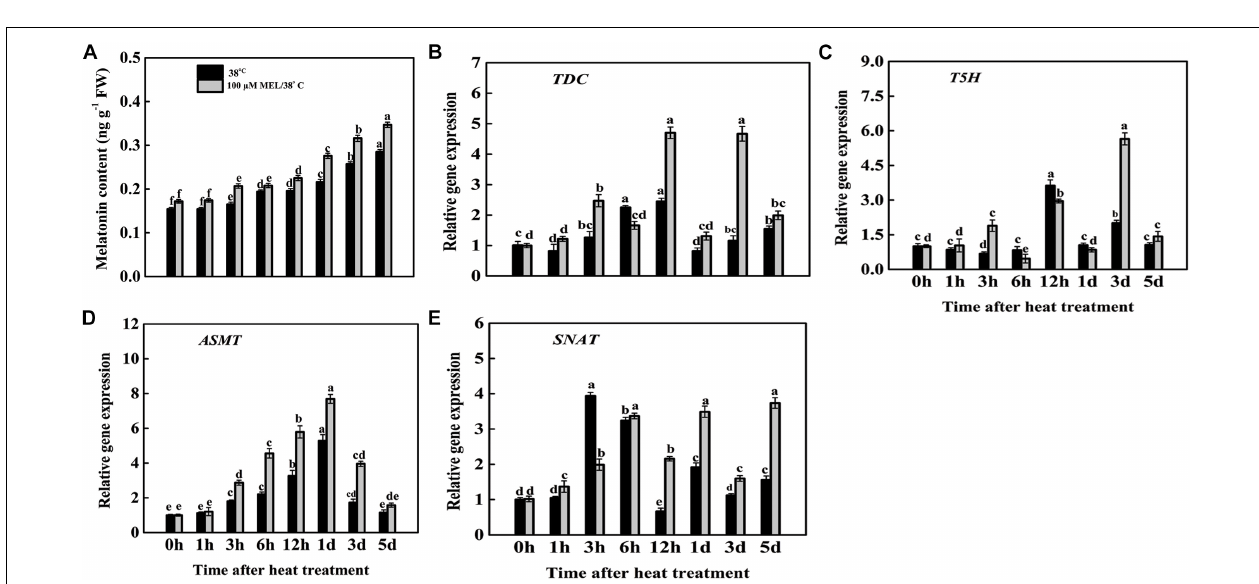
FIGURE 3 | Effects of exogenous melatonin treatment on the transcript abundance of (A–G) chlorophyll catabolic genes ( RCCR, SGR1 , SGR2 , NYC , PAO , PPH , and NOL ) and (H) senescence associated gene ( SAG12 ) during heat stress with or without of melatonin treatment. Different letters denote the significant variations between the treatments and the average values were measured by Tukey’s Honestly Significant Difference (HSD) test at P < 0.05. Data represented as the mean ± standard error of triplicate biological replicates.